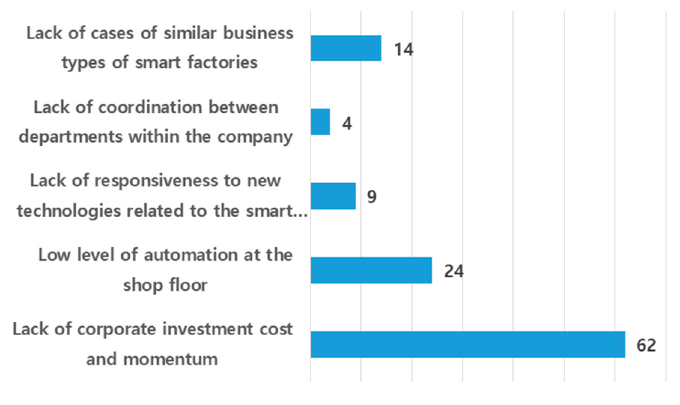
ffi culties in promoting smart Figure 9. Difficulties in promoting smart factory. Figure 9. Di